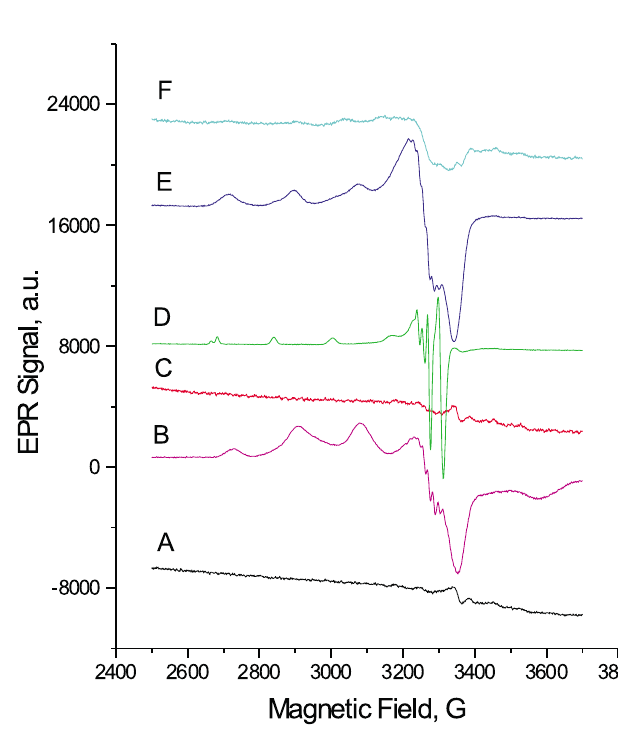
Fig. 1 – EPR spectra of some dinuclear diimine copper(II)